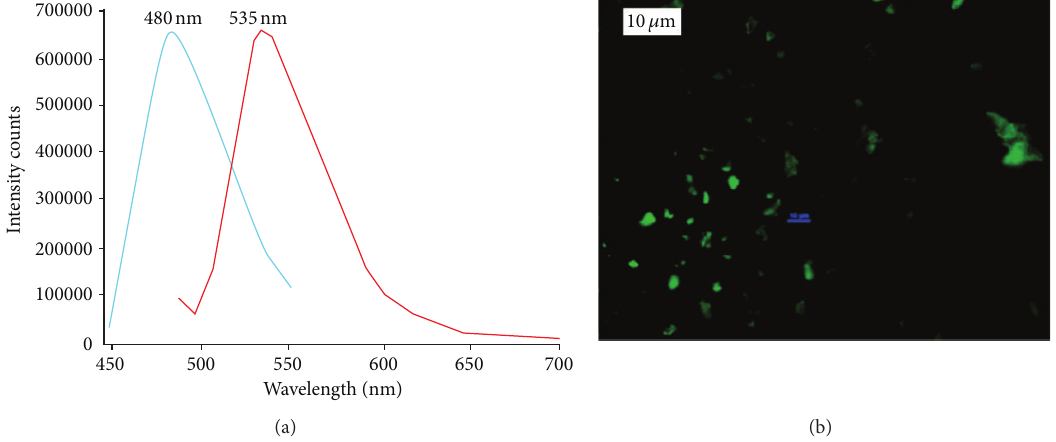
Figure 5: (a) Excitation and emission spectra and (b) fluorescence image of silica nanoparticles.